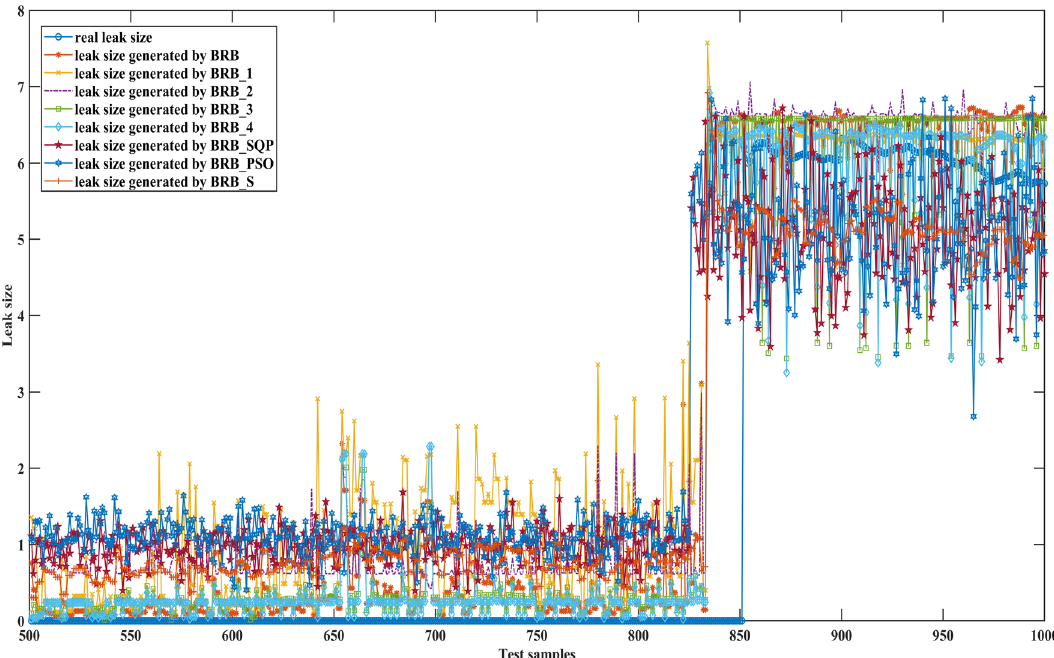
Figure 16. The 501–1000 comparative results generated by different BRBs.